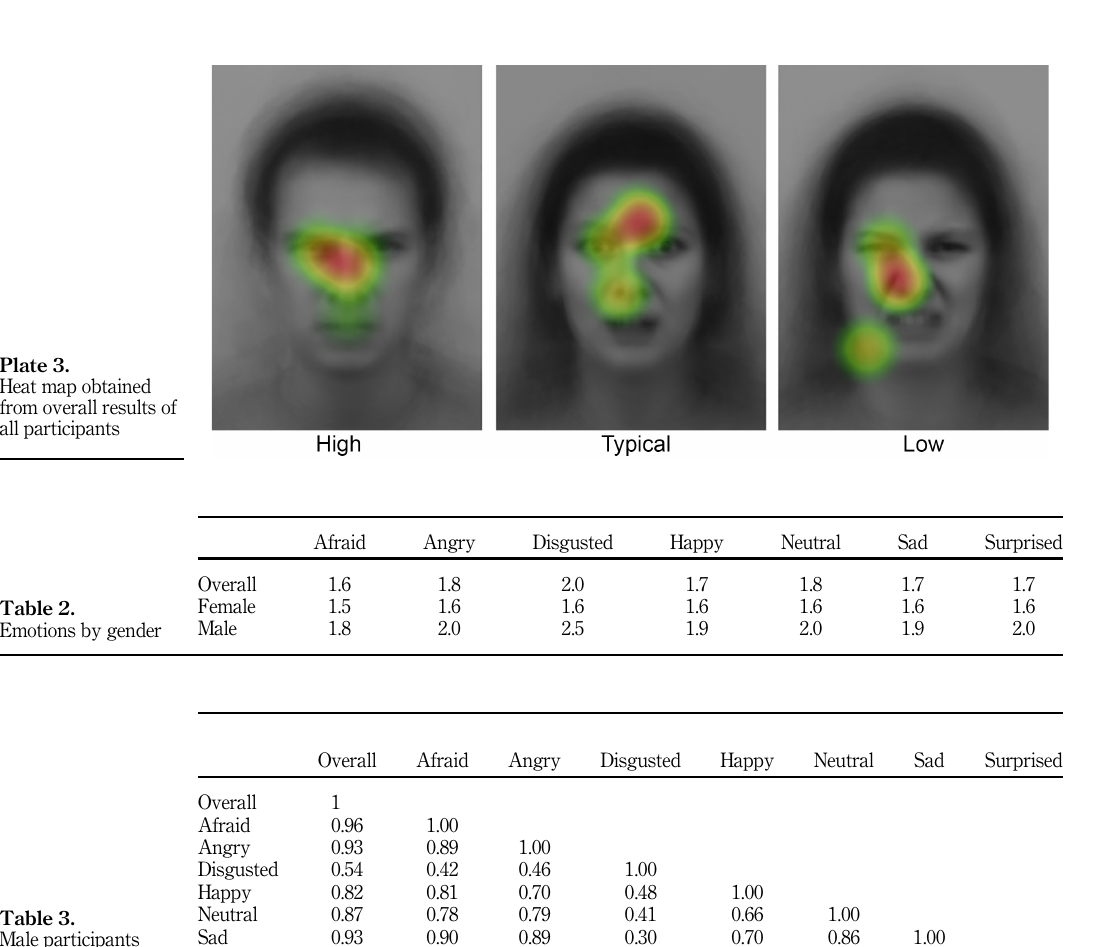
Table 3. Male participants correlation